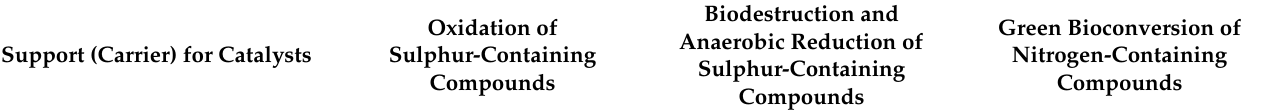
Biodestruction and Green Bioconversion of Oxidation of Anaerobic Reduction of Nitrogen-Containing Sulphur-Containing Sulphur-Containing Compounds Compounds Compounds Chemical Catalysts (NCs)